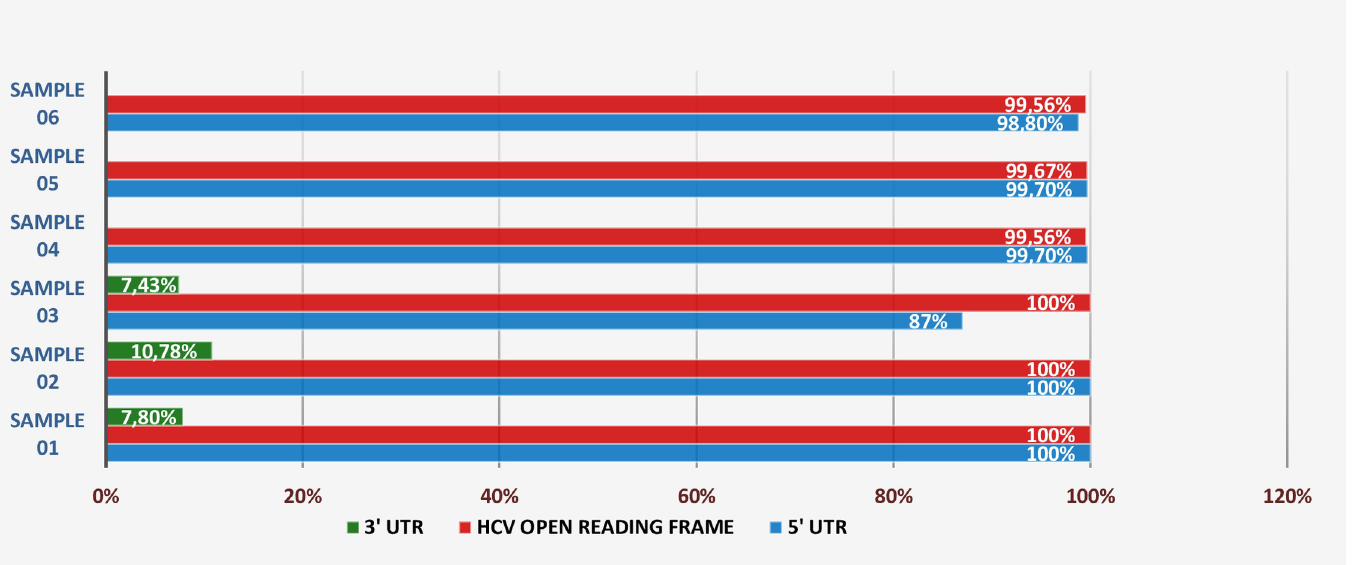
Fig 1. HCV regions obtained (%) by HCV full genome sequencing (compared to AF009606).